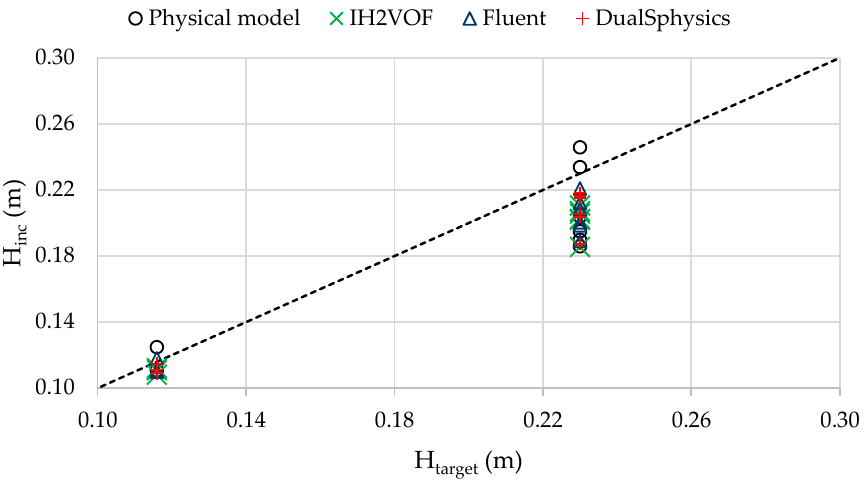
Figure 13. Incident wave height obtained for all cases with h = 0.50, 0.58, and 0.62 m.